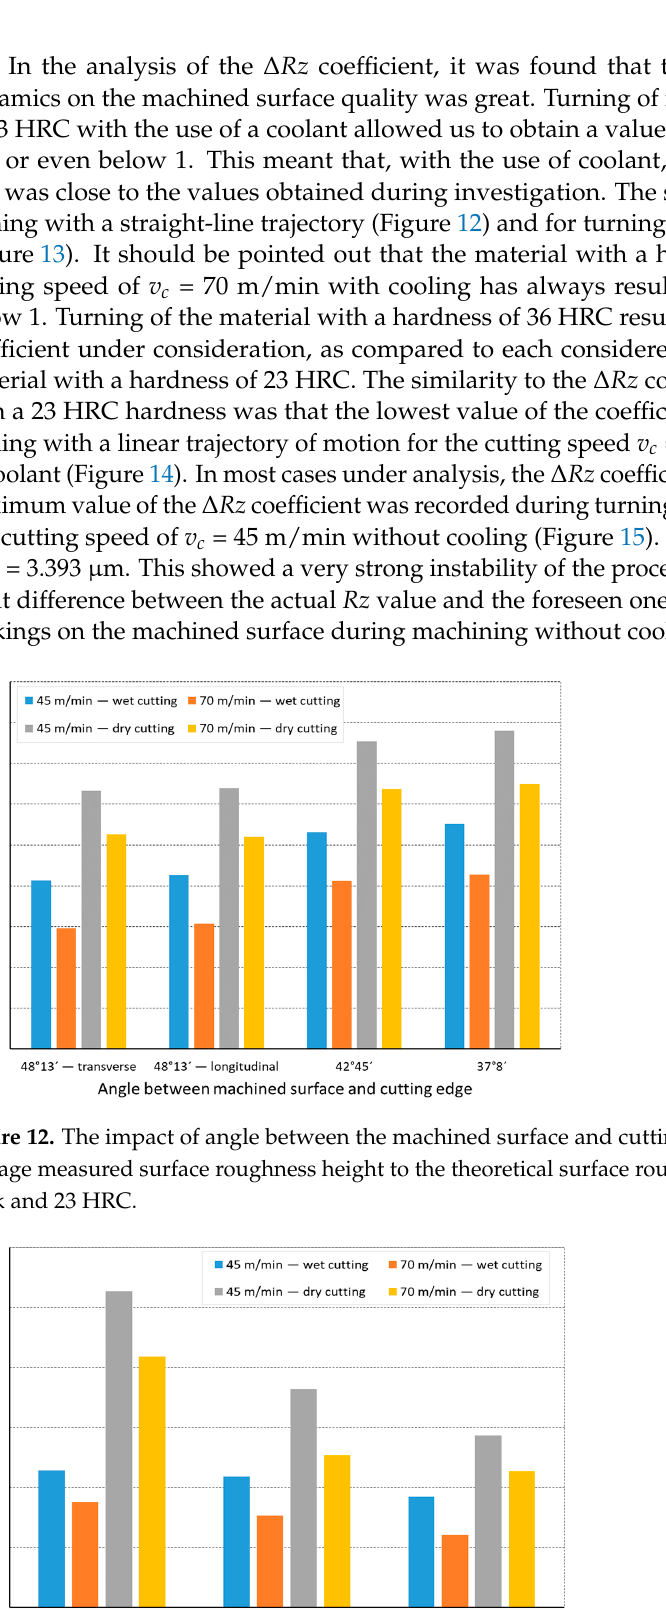
Figure 14. The impact of angle between the machined surface and cutting edge on ratio Δ Rz of the average measured surface roughness height to the theoretical surface roughness Rz to for a rectilinear track and 36 HRC. Figure 15. The impact of angle between the machined surface and cutting edge on ratio Δ Rz of the average measured surface roughness height to the theoretical surface roughness Rz to for a curvilin- ear track and 36 HRC.